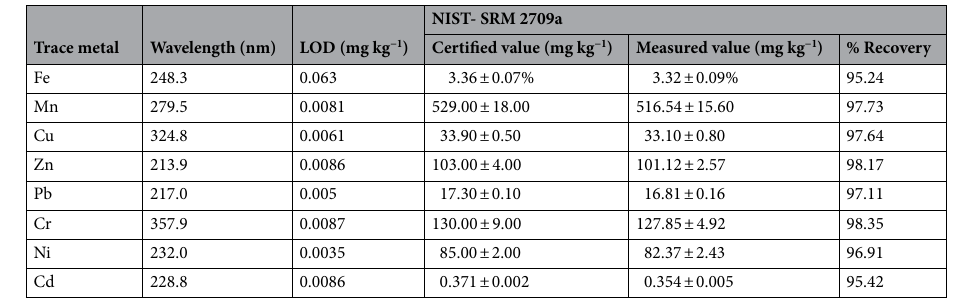
Table 1. Detection limit (LOD) and % recovery of the studied eight trace metals.